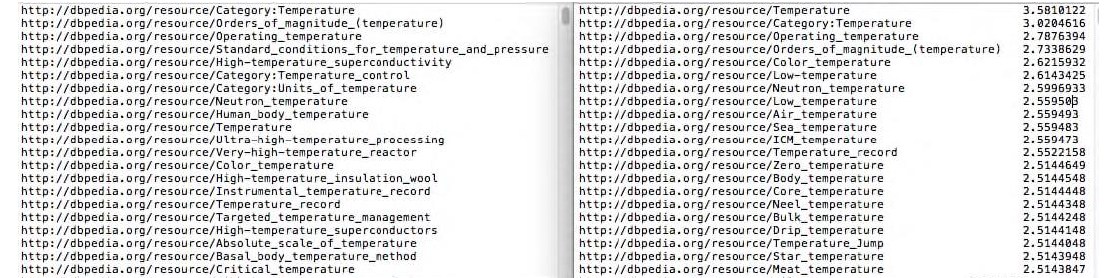
Figure 15. The top-N ranking lists of parts of the candidate entities before and after re-ranking. The left figure is the initial ranking list before re-ranking, while the right figure is the re-ranked top-N lists with ranking scores. Table 1. Accuracies of ground truth ranked in top 10 and top 1 for the SVM ranking model. The values in bold are re-ranked accuracies which show that re-ranking model improves the results compared to initial ranks.